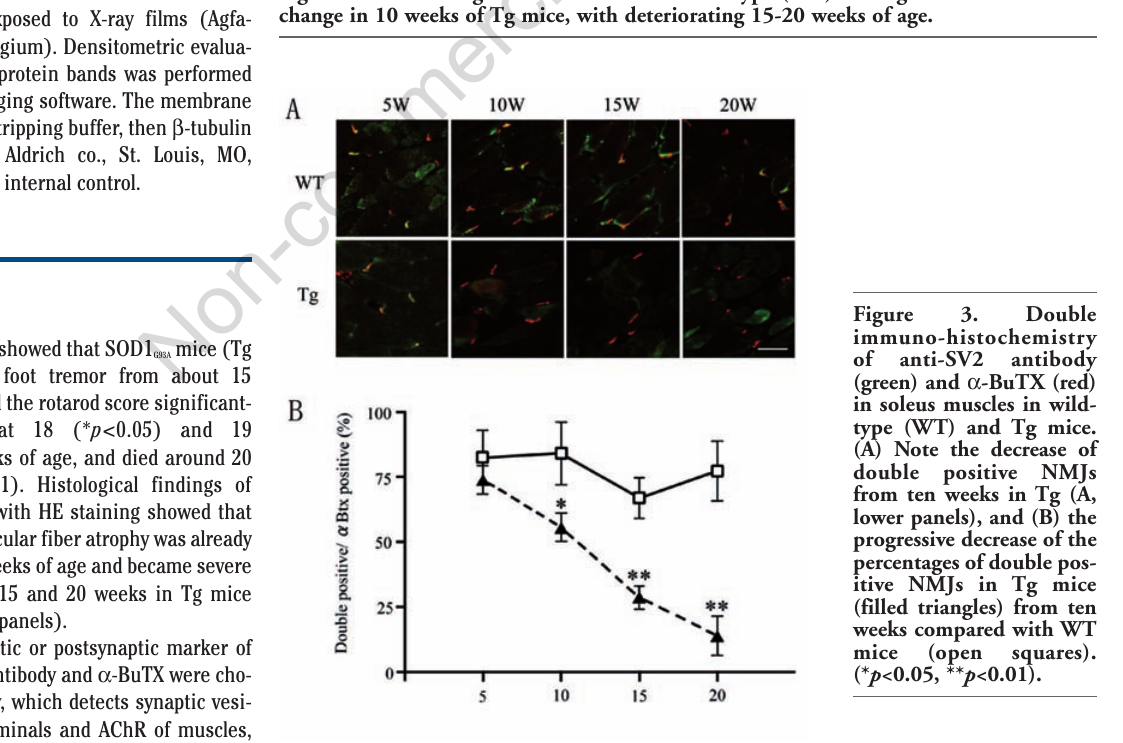
tively), which then decreased in Tg mice through the time from ten weeks (62.5±13.8%